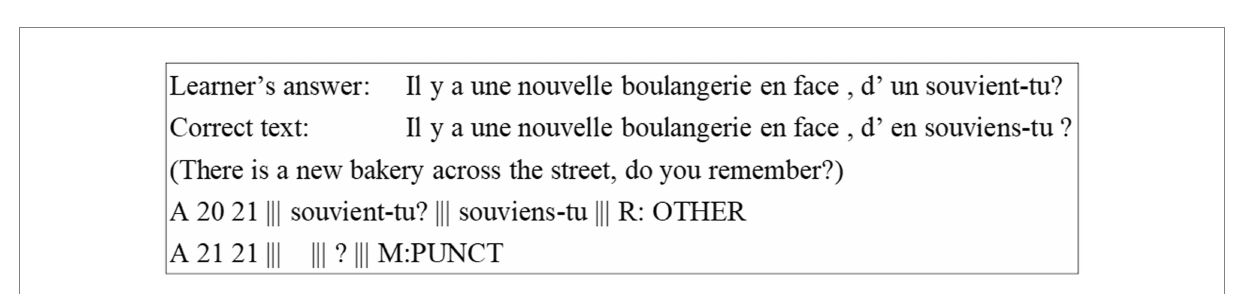
FIGURE 5 An example of noise introduced by automatic edit